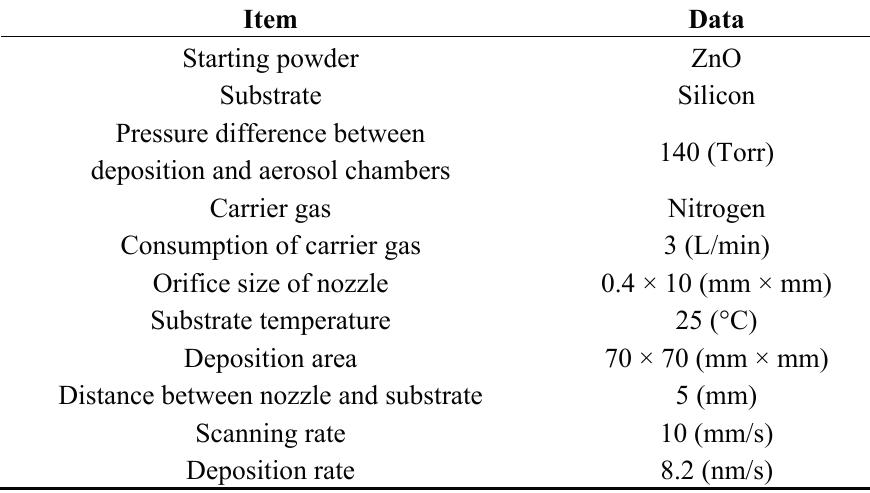
Table 2. Process parameters for ZnO films deposited by the AD